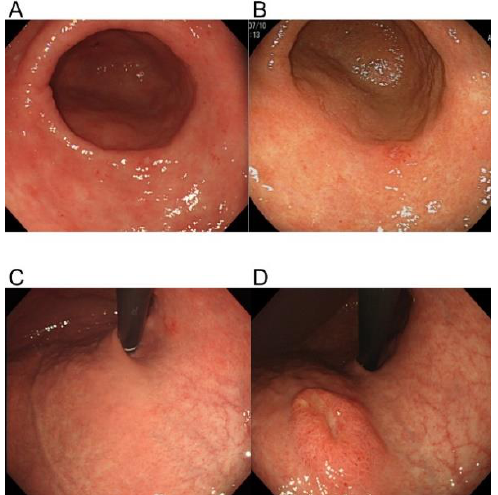
Figure 1. Representative lesions showing slow and rapid gastric cancer growth. A slow-growing lesion at two years before diagnosis ( A ) and at the time of diagnosis ( B ). The site of a rapidly growing lesion at two years before diagnosis ( C ) and at the time of diagnosis ( D ).